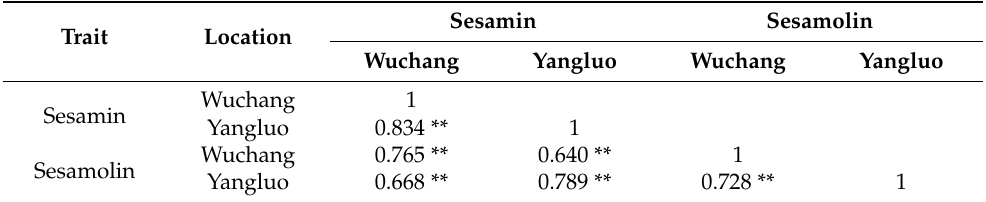
Table 2. Pairwise correlation coefficients between sesamin and sesamolin across two environments.